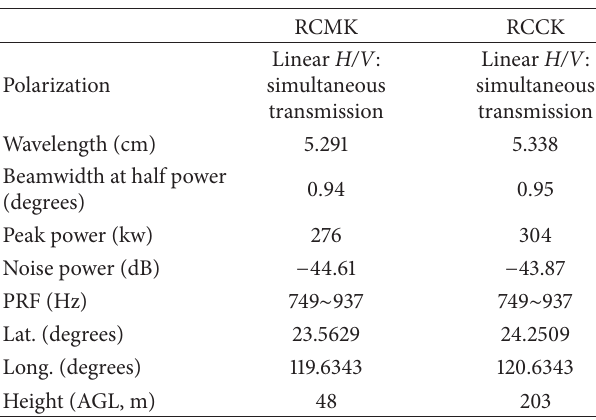
Table 1: Technical specifications of two C-band polarimetric radars (RCMK, RCCK) used in the current